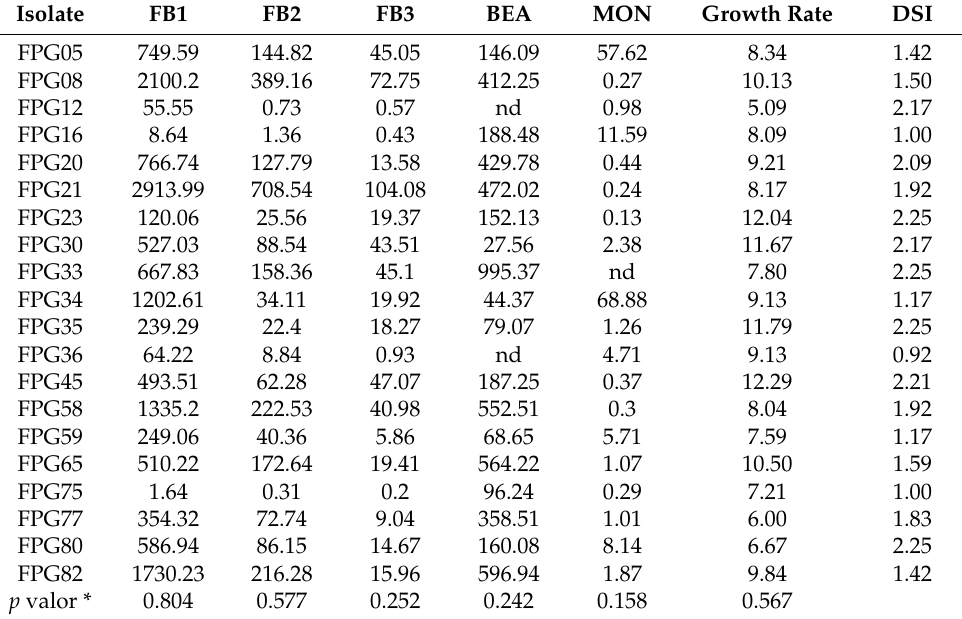
Table 4. Description of the F. proliferatum isolates indicating their growth rates (mm/day), DSI values of inoculated garlic cloves and levels (in µ g/g) of fumonisins (FB 1 , FB 2 , and FB 3 ), beauvericin (BEA), and moniliformin (MON) produced on rice grain substrate in